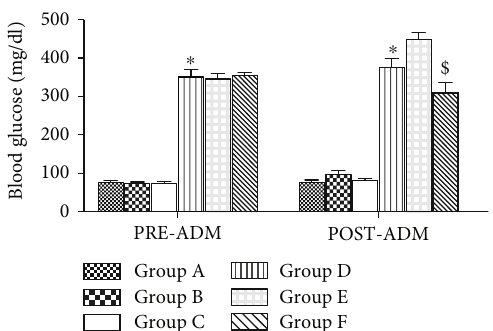
Figure 6: Blood glucose level for pre- and postadministration in nondiabetic groups: vehicle (A), HAART (B), and HAART-AgNPs (C), and diabetic groups administered with vehicle (D), HAART (E), and HAART-AgNPs. ∗ p < 0 : 05 vs. group A (nondiabetic control); $ p < 0 : 05 vs. group E